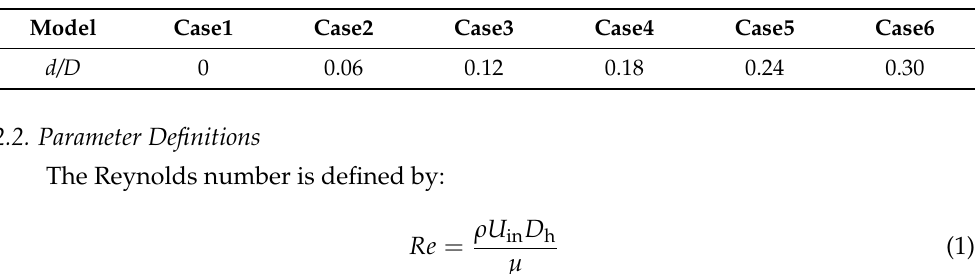
Table 2. Thickness of the turning vanes in different